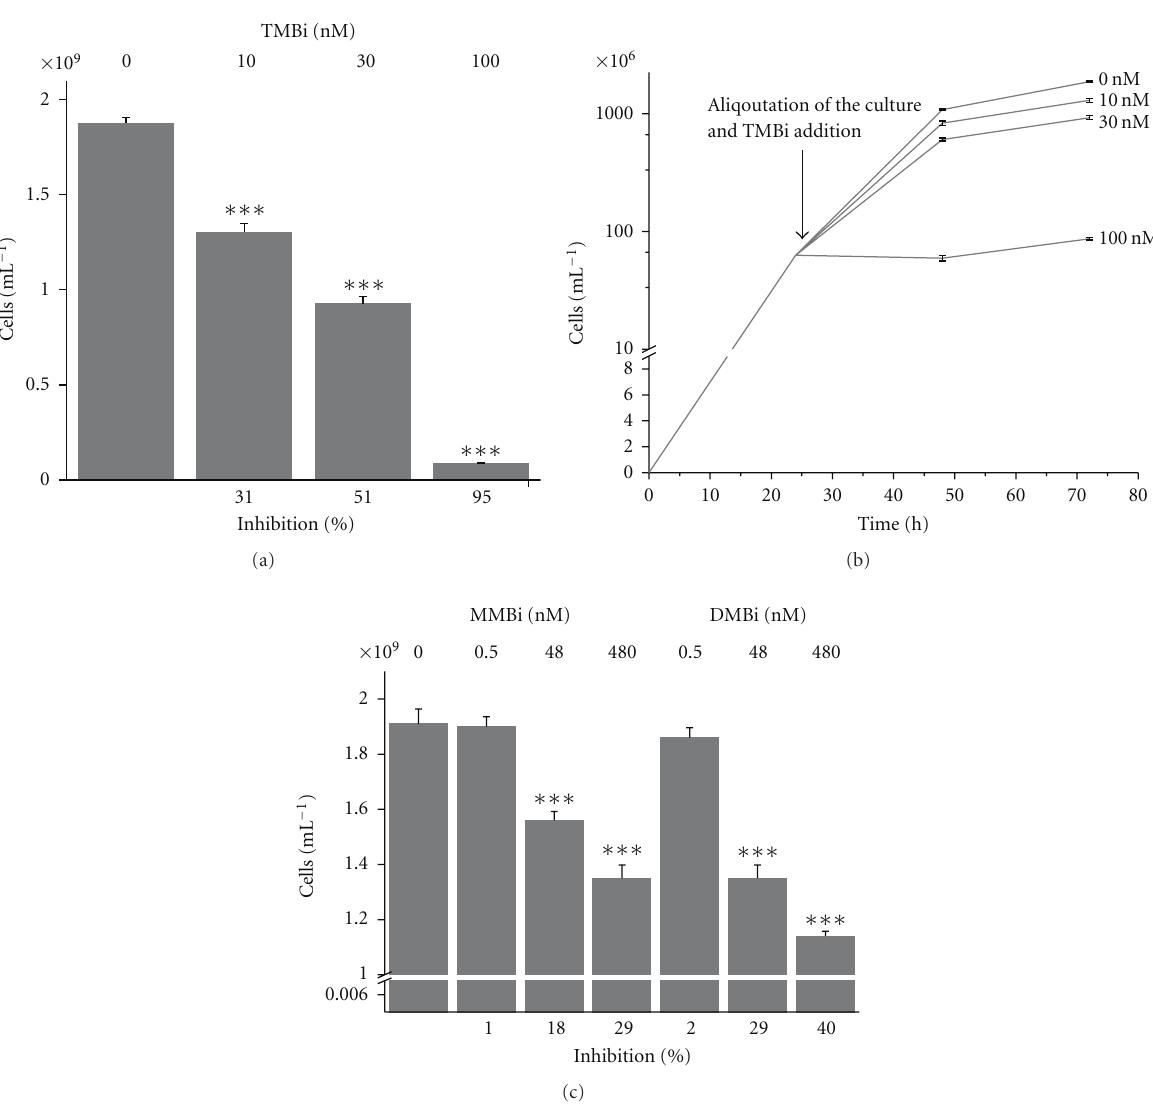
Figure 2: Growth inhibition of B. thetaiotaomicron 48h after exposure of methylated bismuth species ( n = 3). The addition of TMBi (a) to the headspace or of nonvolatile methylated bismuth species MMBi and DMBi (c) to the liquid phase of growing B. thetaiotaomicron cultures resulted in a growth reduction in a concentration-dependent manner. Figure 2(b) shows the growth curve in the presence of TMBi. The culture was separated in aliquots in the late exponential phase and was exposed to di ff erent TMBi concentrations. The cell counts were determined after 48h at the stationary